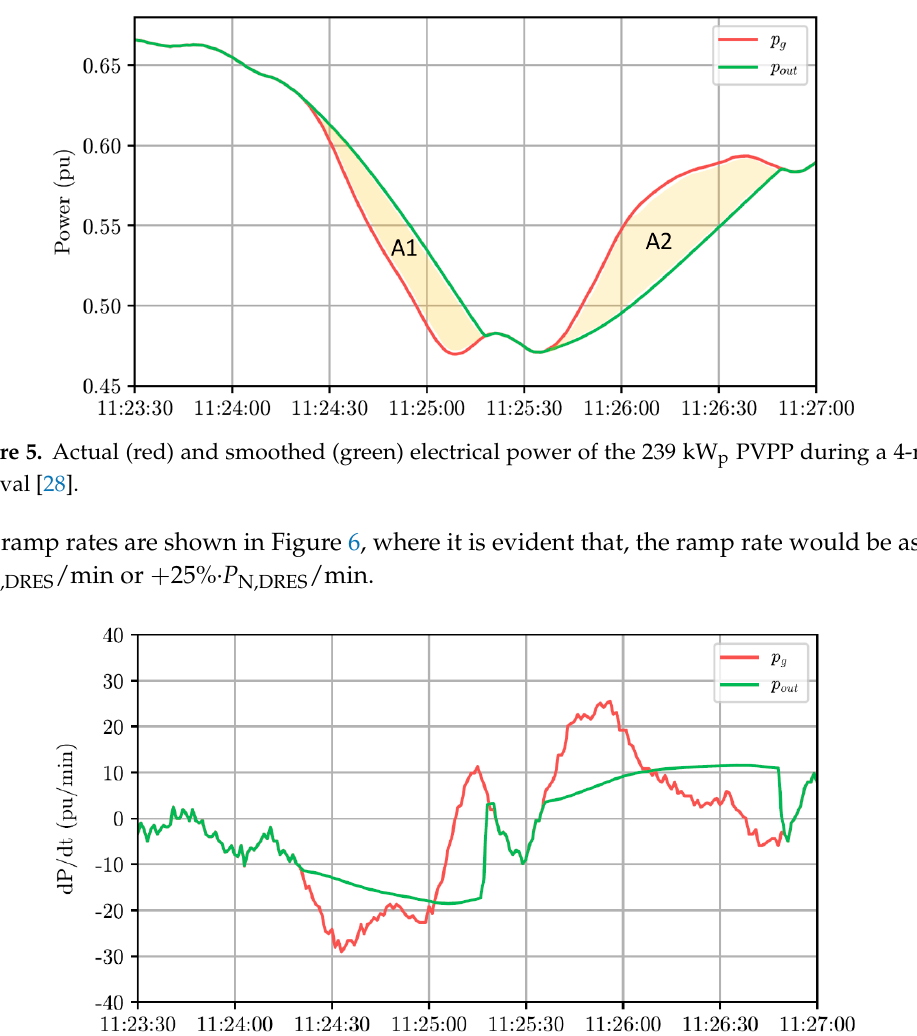
Figure 6. Evaluation of ramp-rates without (red curve) or with (green curve) power smoothing.